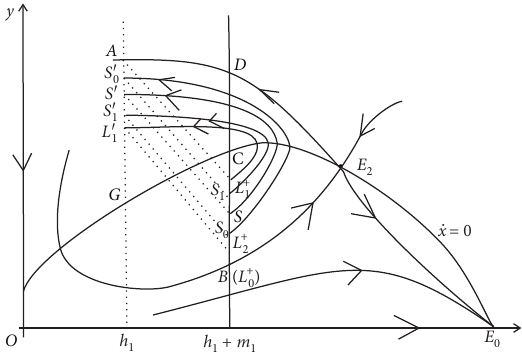
Figure 4: Existence of attraction region of system